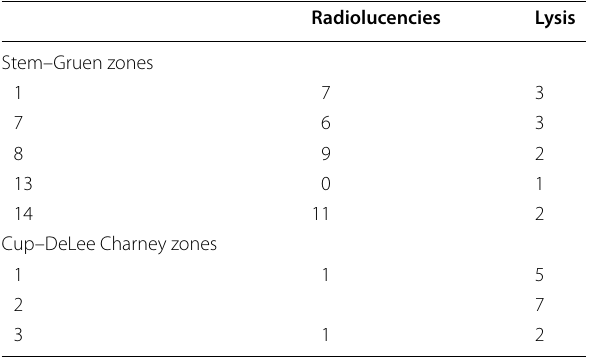
Table 2 Number of implants with radiolucencies or lysis around the stem or the cup Radiolucencies